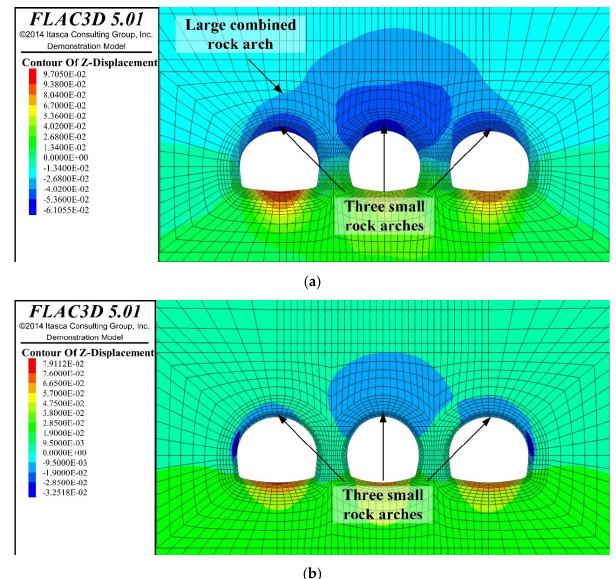
Figure 14. Ground settlement of triple tunnels: ( a ) without PRPS or CGPR (Case 1); ( b ) with PRPS and CGPR (Case 2).